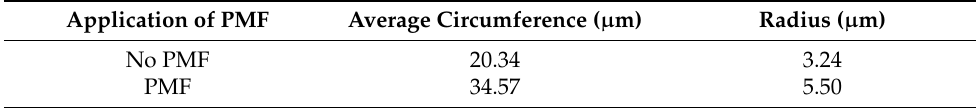
Table 2. Analysis results of extracted inclusions.